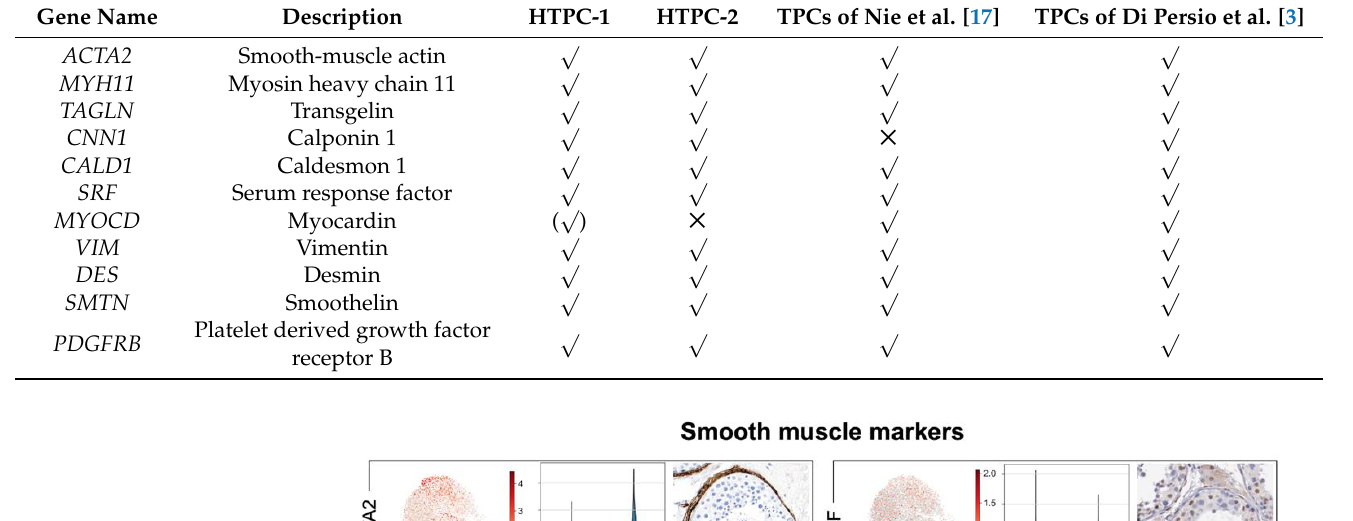
Table 1. Smooth muscle cell marker transcripts in HTPCs and comparison with the data of ex vivo studies of Di Persio et al. [3] and Nie et al. [17]. in brackets, indicates weak expression.